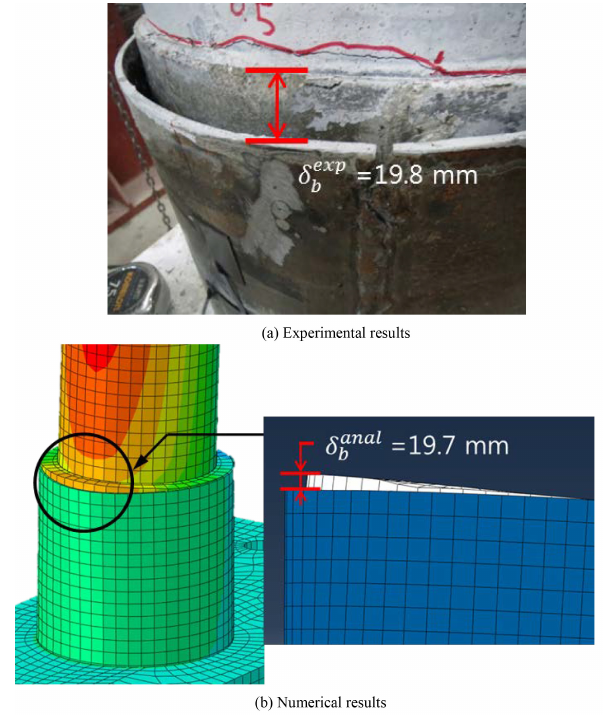
Figure 17. Development of slip at the interface between in-filled concrete and steel